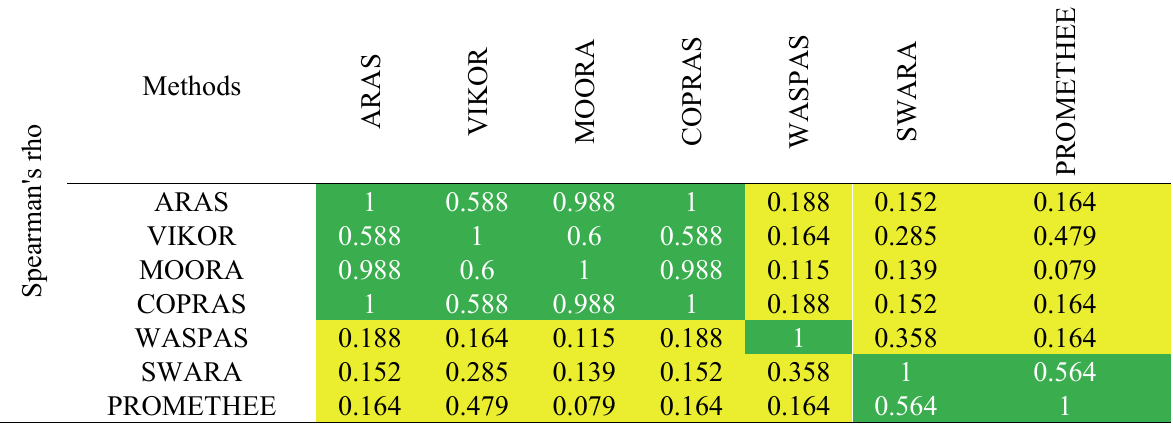
Table 6 Spearman Correlation